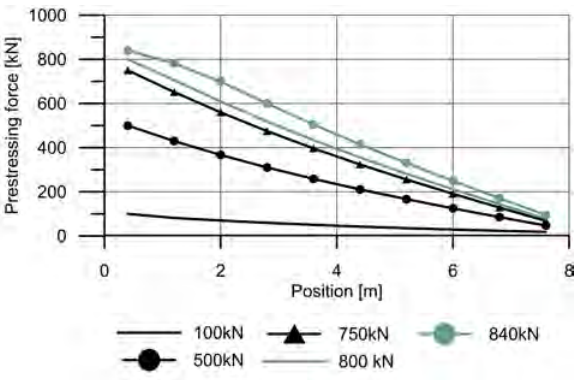
Figure 14. Pre-stressing force distributions.